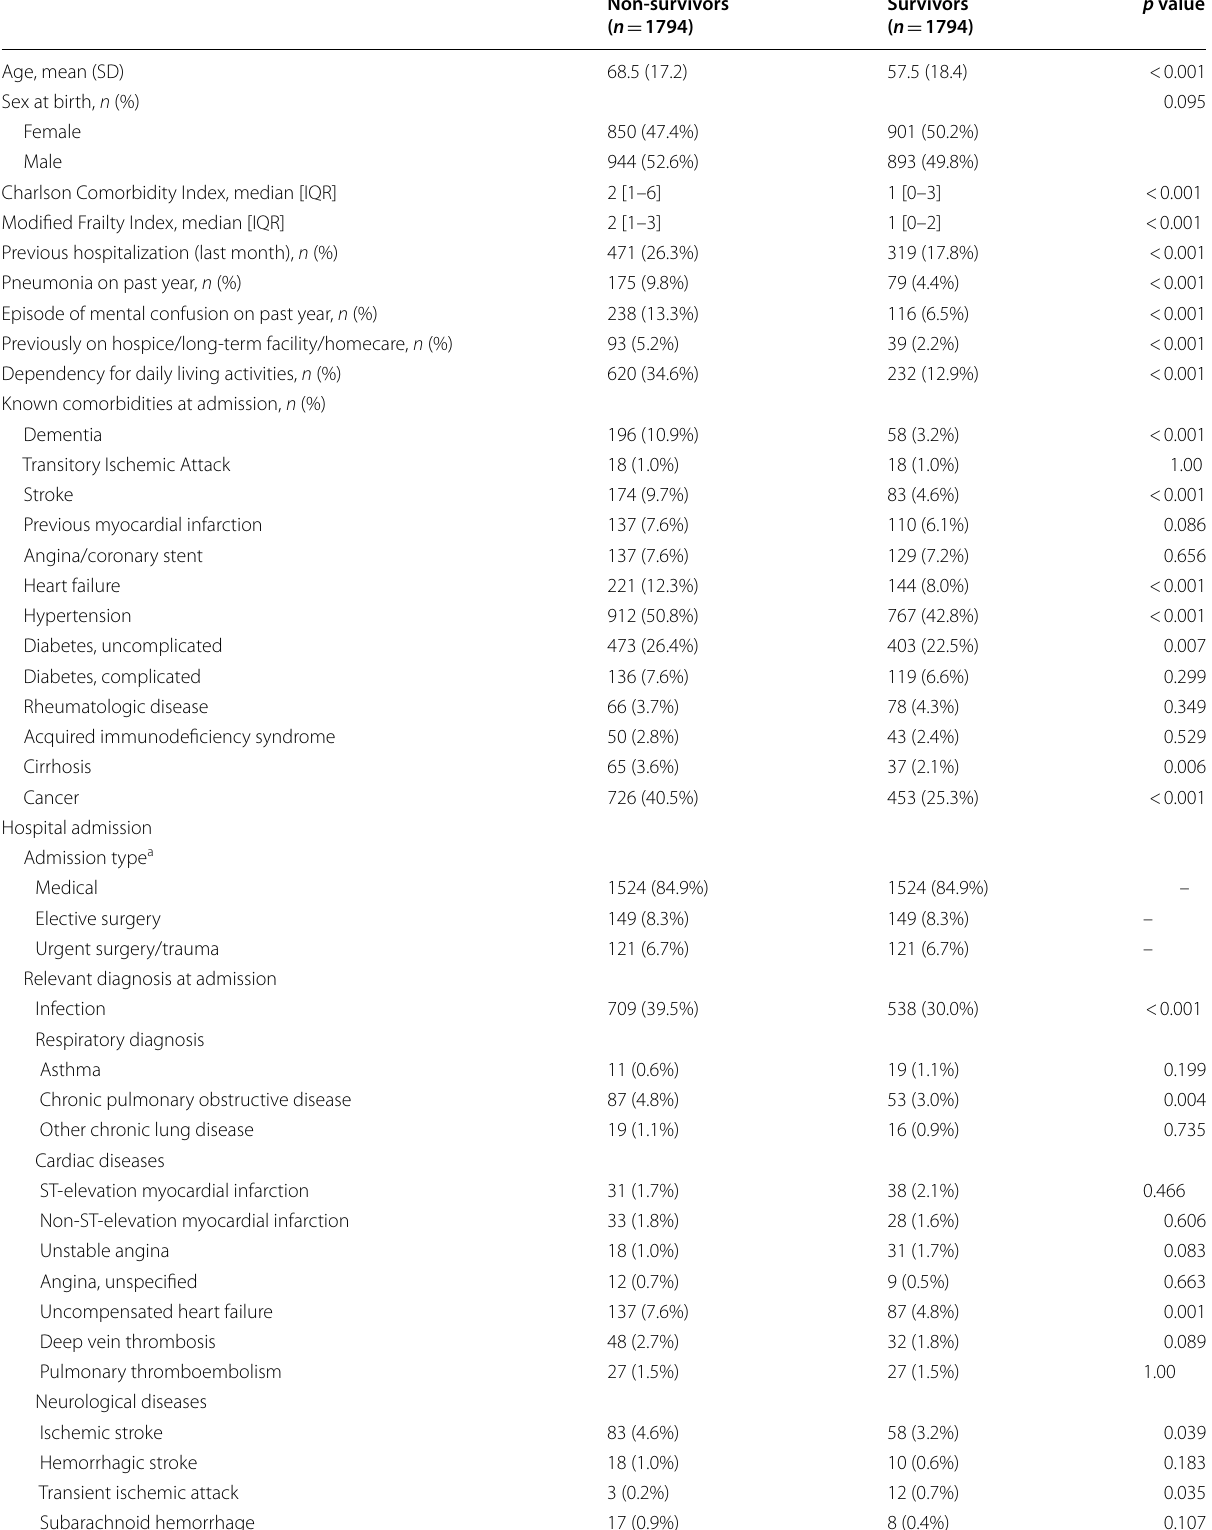
Table 2 Patient features, resource use and occurrence of clinically relevant events in cases and